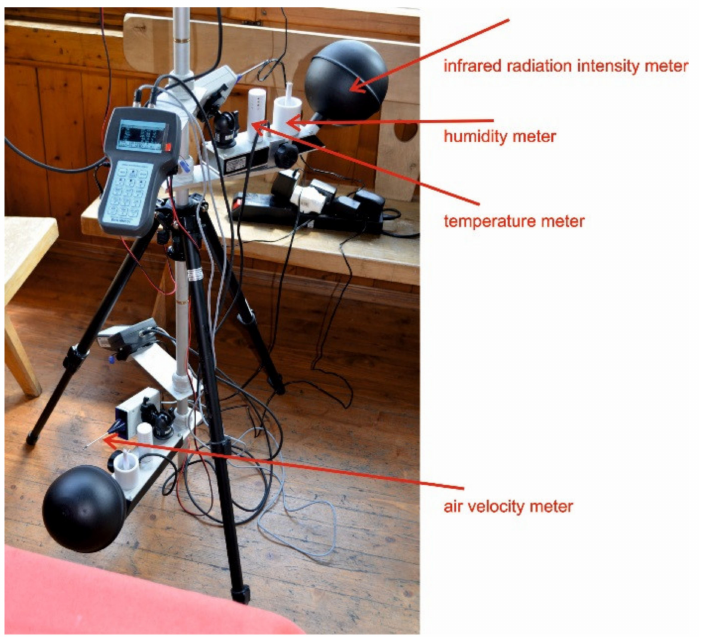
Figure 9. Microclimate measurement station in the Stara Polana building in a south-facing, glazed hall. Reproduced from [22].